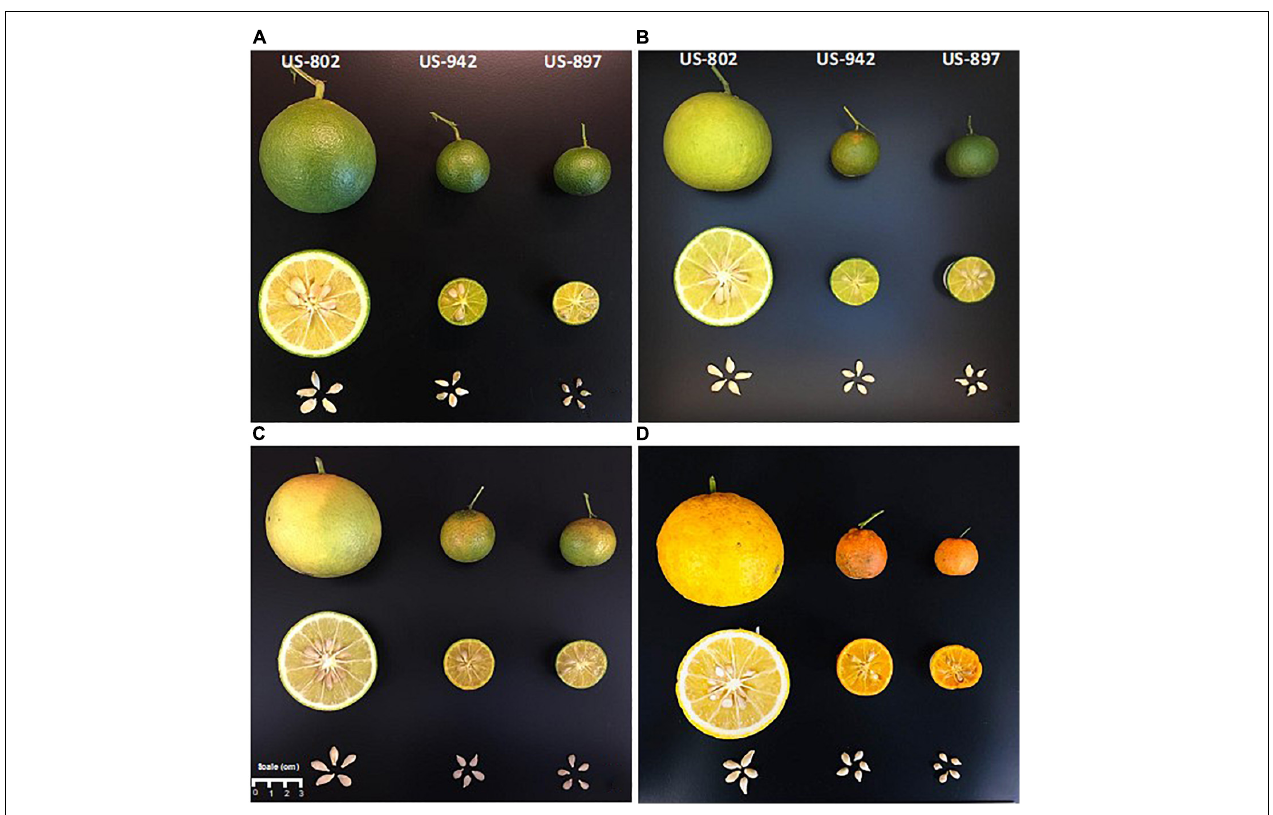
FIGURE 2 | Flavedo color development of citrus rootstock fruits and seed comparison during different harvest periods in mid-July (A) , mid-August (B) , mid-September (C) 2020, and mid-December (D)